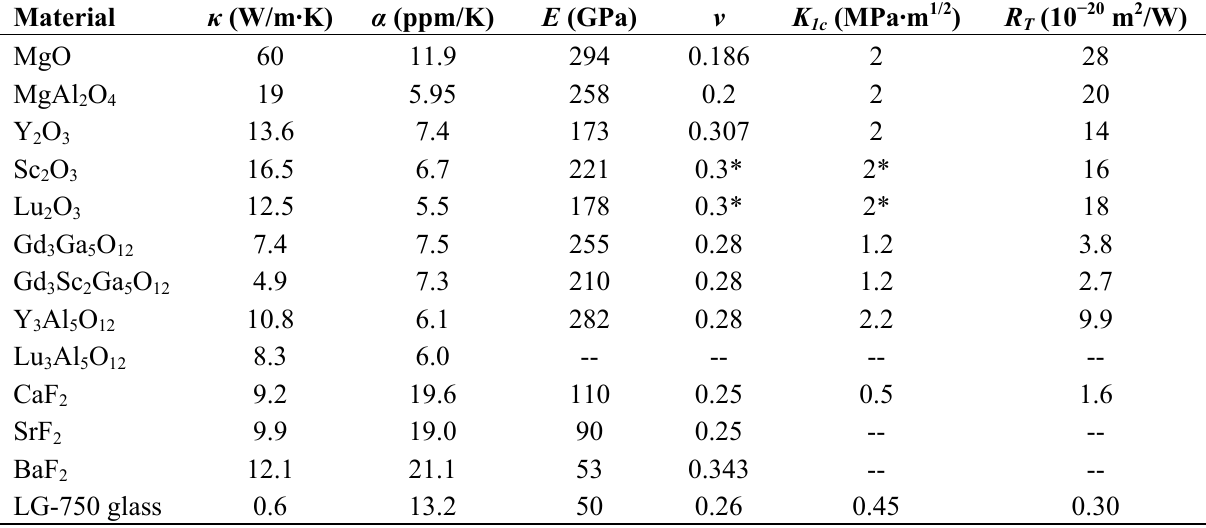
Table 1. Properties of some cubic single crystal materials, including laser glass (LG-750) [11]. Material